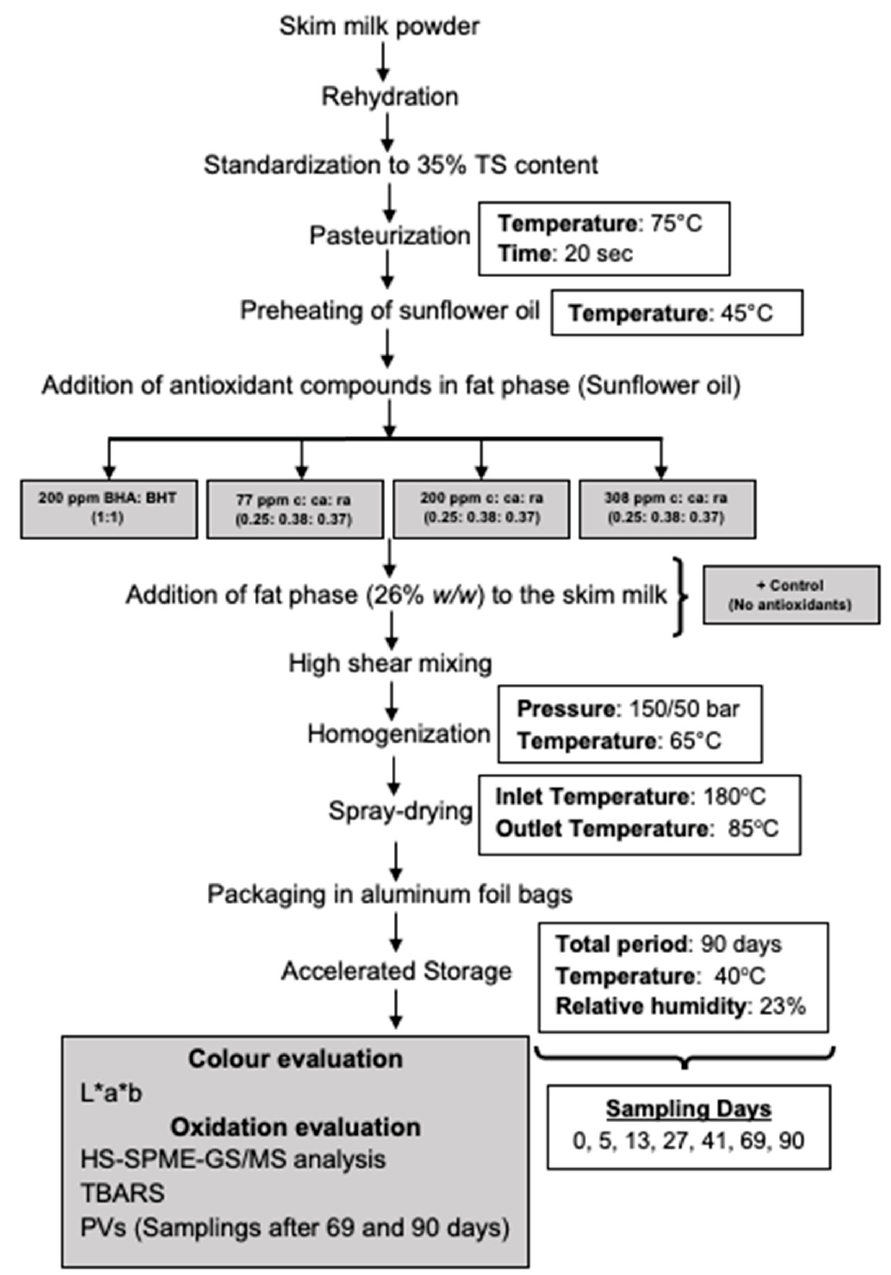
Figure A1. Schematic diagram of FFMP production with or without the addition of antioxidant compounds. Table A1. PVs of the FFMPs after accelerated storage (40 °C, RH 23%) for 69 and 90 days, with or without the addition of antioxidants 1, 2, 3, 4 .